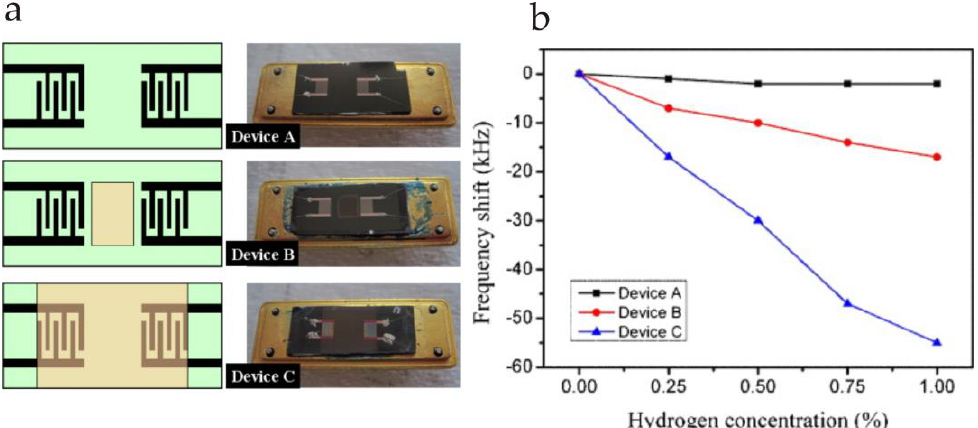
Figure 6. ( a ) SAW devices A (uncoated), B (conventional Pt/ZnO layer) having a chemical recognition layer between two sets of IDTs and device C (layered Pt/ZnO) which has a sensor layer extended on IDTs. ( b ) Sensor response of three devices A , B and C measured at room temperature and relative humidity of 30% for H 2 gas (0–1%). Adapted with permission from [76], copyright